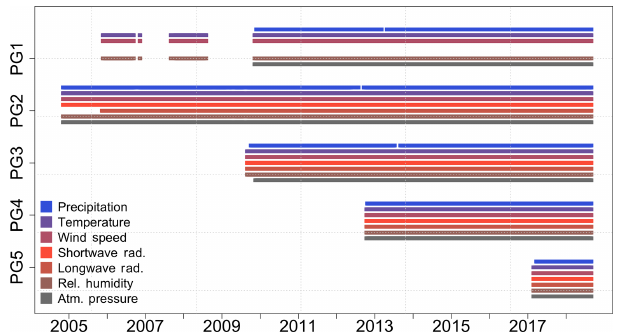
Figure 3. Recording period and data availability for each weather station and variable in the Guadalfeo Network (Sierra Nevada, Spain) since